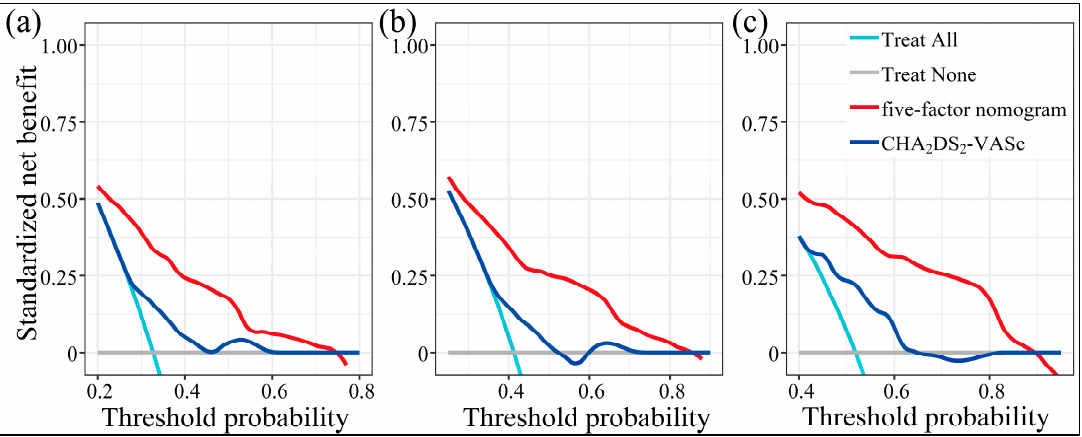
Figure 7. Decision curve analyses across 1 ( a ), 2 ( b ), and 3 years ( c ) after ablation.